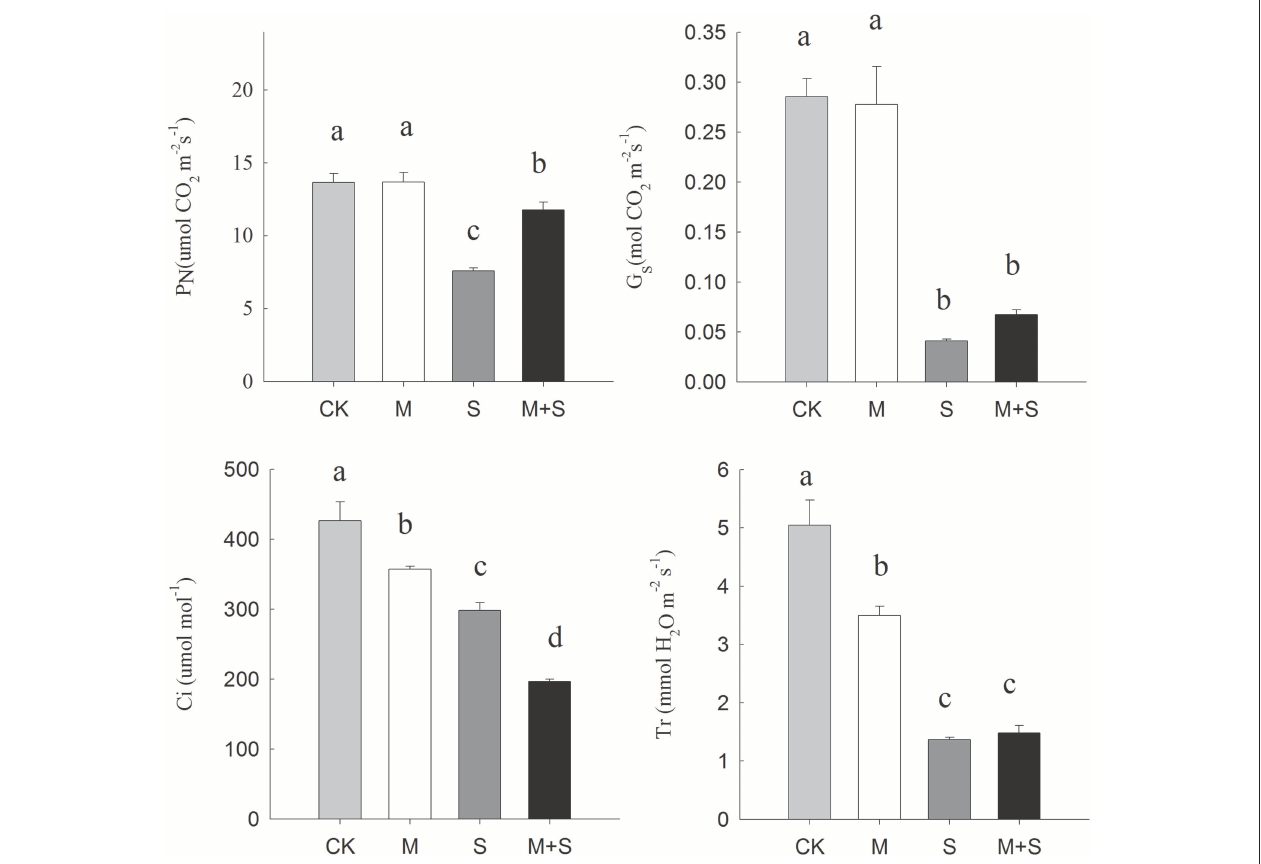
FIGURE 2 | Effects of NaCl with/without melatonin on gas exchange parameters in tomato seedlings. PN, net photosynthetic rate; Gs, stomatal conductance; Ci, intercellular CO 2 concentration; Tr, transpiration. The results were calculated from data for 12-day, salt-stressed leaves. CK, control; M, 150 µ M